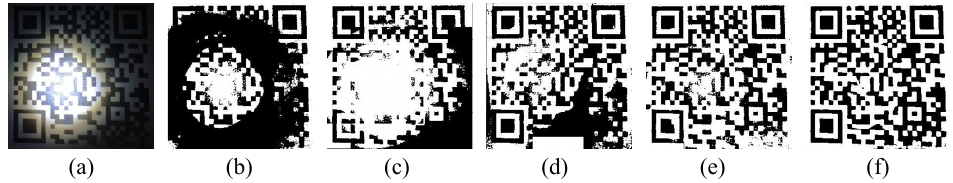
(f) Figure 18. The original image and experimental results of different algorithms: ( a ) Original image; ( b ) Sauvola’s algorithm [6]; ( c ) Yao’s algorithm [18]; ( d ) Di’s algorithm [8]; ( e ) Chen’s algorithm [13]; ( f ) Proposed method. According to the groups of experiments above, we obtained the values of PSNR and SSIM of different QR codes after using different algorithms. The exact data values are shown in Table 4. In order to compare the values more intuitively, we drew Figure 19 based on the data in Table 4. Table 4. The values of PSNR and SSIM of different QR codes after using different algorithms. Sample